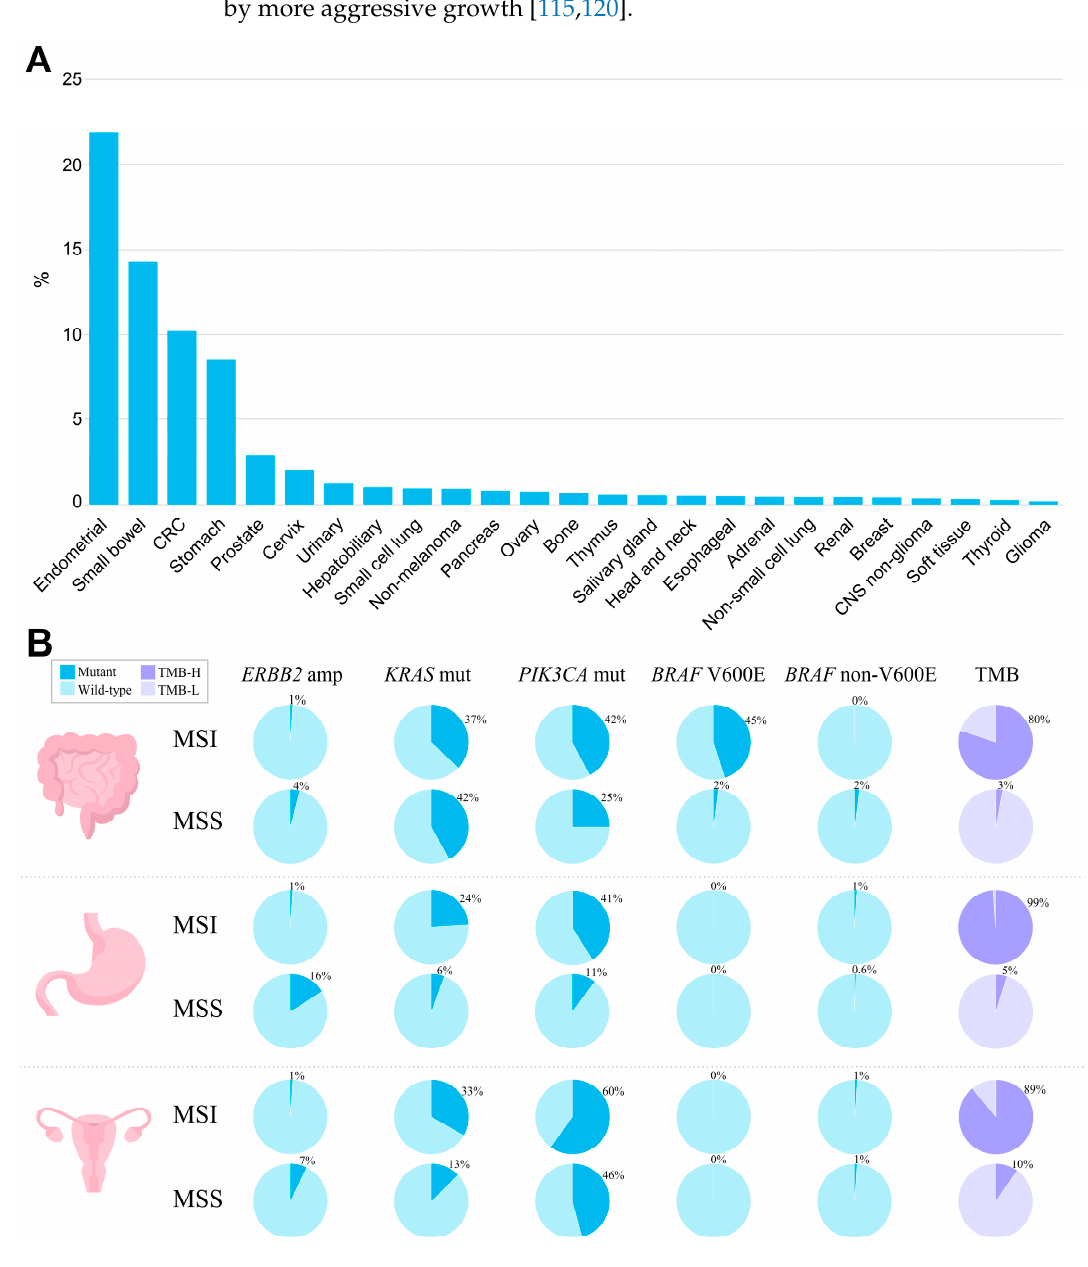
Figure 2. The landscape of MSI and genomic characteristics of MSI tumors across cancer types, according to TCGA. ( A ) Prevalence of MSI (%) across tumor types. ( B ) Prevalence of genomic alterations typically found in MSI and MSS tumors in colorectal adenocarcinoma, stomach adenocarcinoma, and uterine corpus endometrial carcinoma.